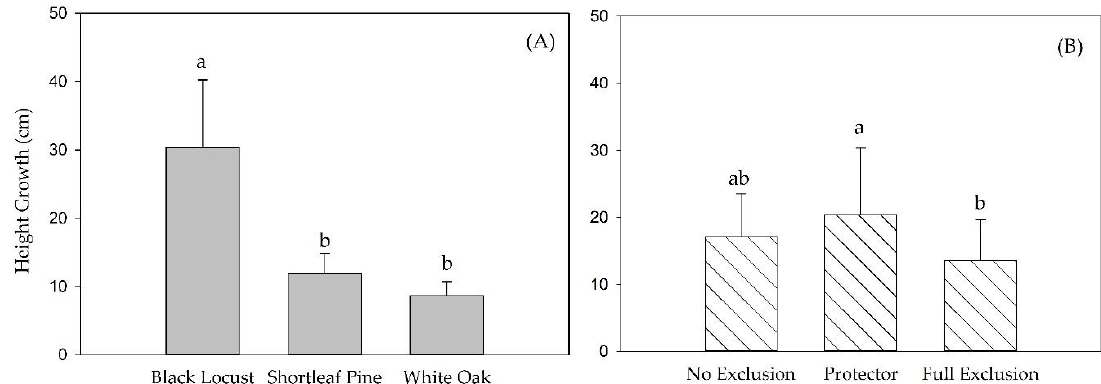
Figure 2. First growing-season height growth (Mean ± SE) among ( A ) tree species and ( B ) herbivore exclusion treatments on reclaimed Appalachian mined lands in southeastern KY. Different letters indicate significant differences among effect level means.